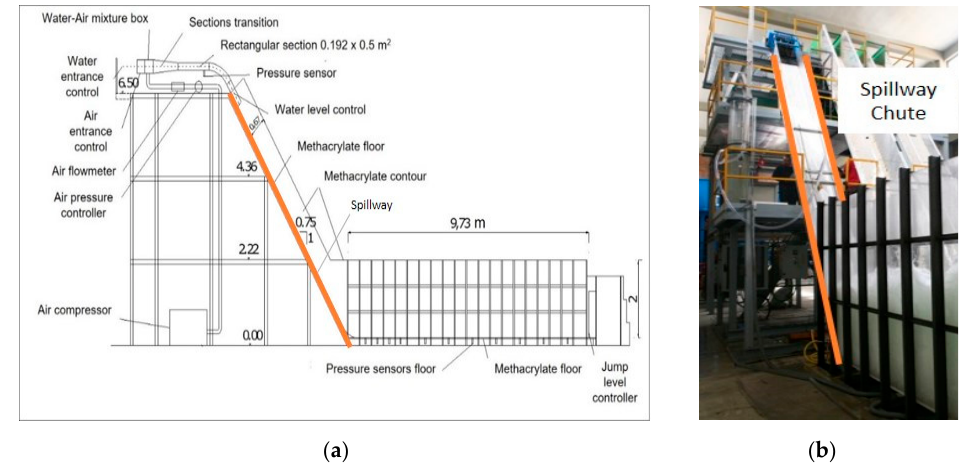
Figure 1. Design and characteristics of the physical model with spillway limits (orange color): ( a ) Model longitudinal section with materials and all the elements needed to establish the initial and boundary conditions and to reproduce the flow scenarios; ( b ) Lateral view of the spillway chute and stilling basin with the hydraulic